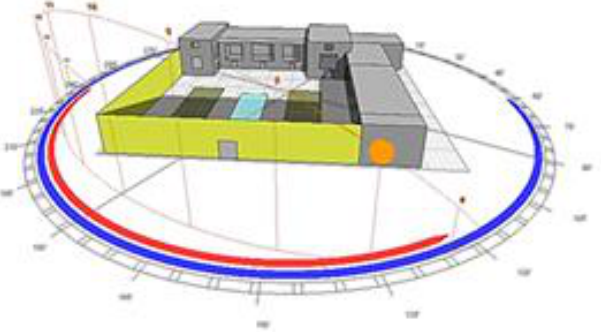
Figure 8 3D view of house No. 1 (7:00 am, January)